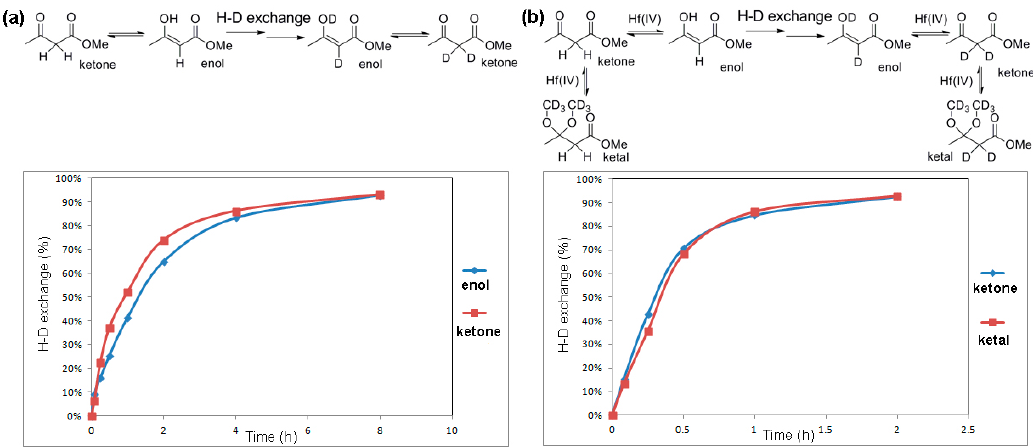
Figure 3. The H-D exchange reactions of methyl acetoacetate in MeOH- d 4 in the absence ( a ) or presence ( b ) of Hf(OTf) 4 .